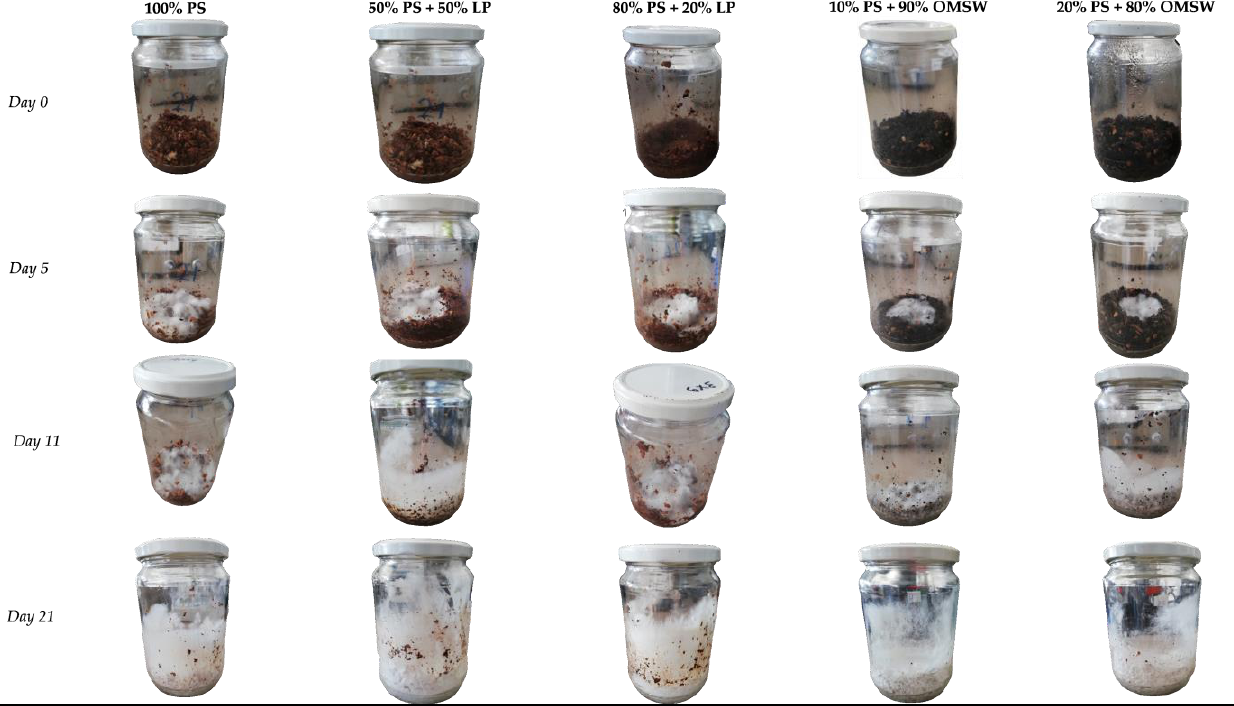
Figure 1. Representative images of mycelial growth for PS and its additions of 10% w / w , 20% w / w , 50% w / w and 20% w / w to OMSW and LP, respectively, at the beginning (Day 0) and at end of fermentation (Day